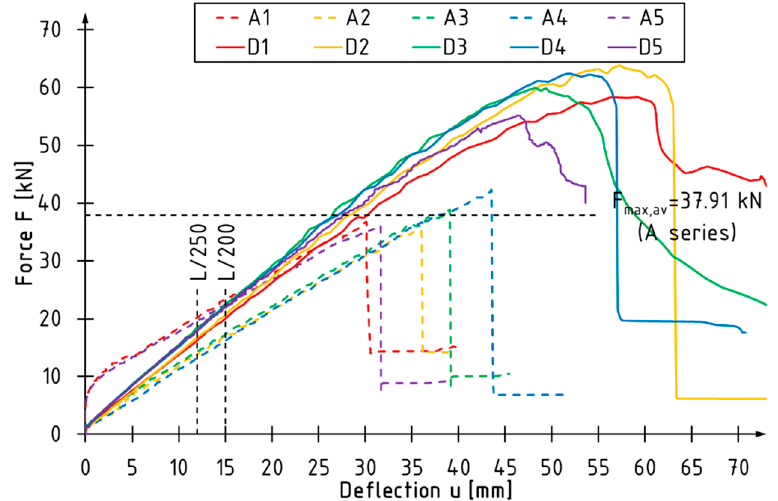
Figure 4. Load-deflection curves of C series beams.